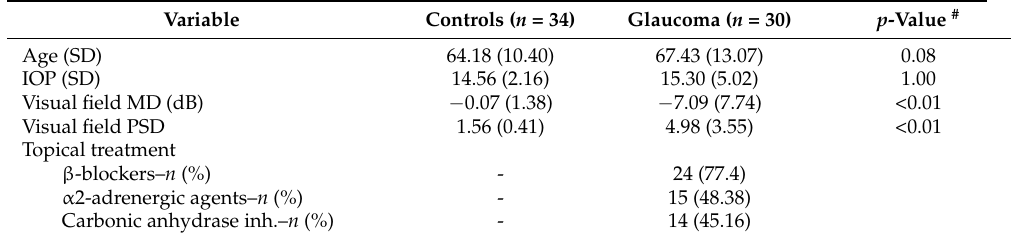
Table 1. Study population characteristics.